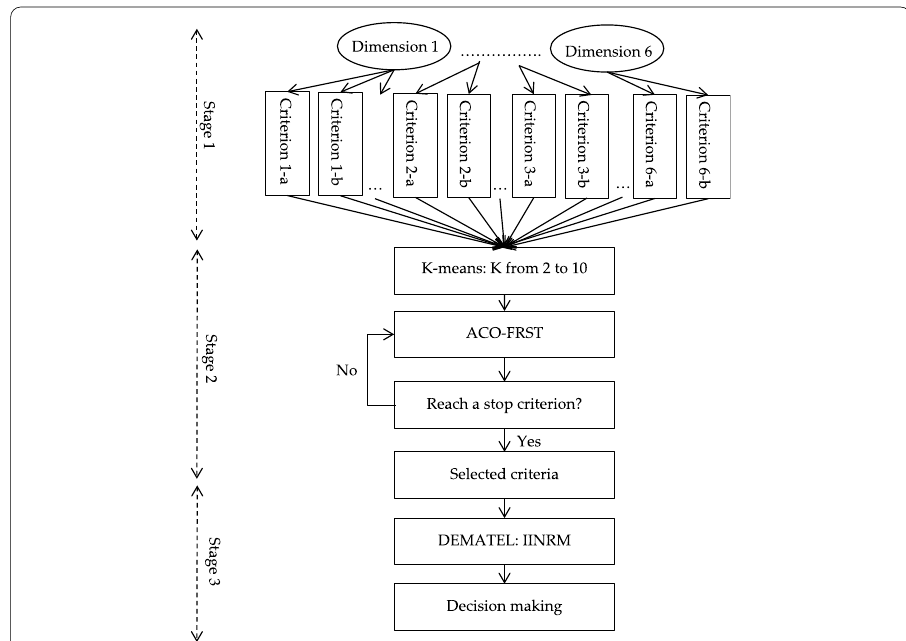
Fig. 2 The architecture of a three‑stage questionnaire